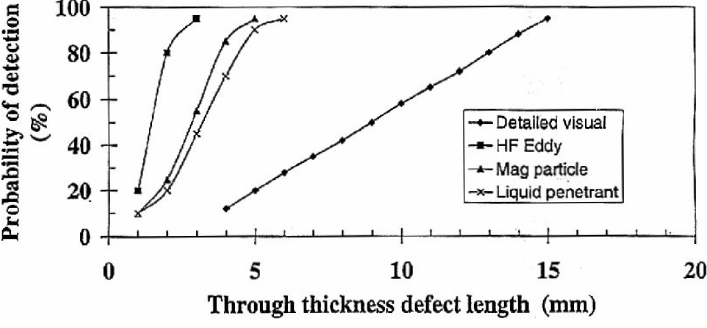
Fig. 1. Probability of Detection at 95% confidence of selected NDT